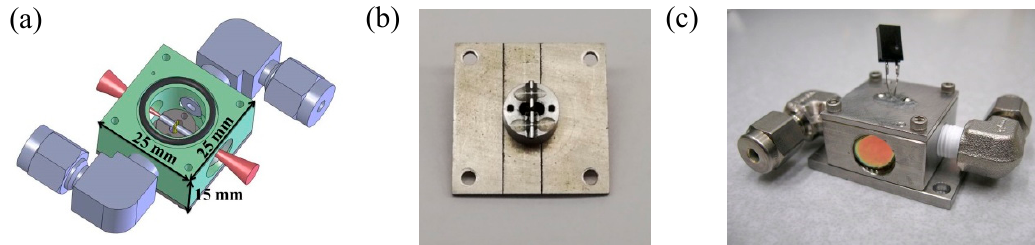
Figure 6. ( a ) CAD image of the free space MIR ADM; ( b ) photo of the top cap with spectrophone; ( c ) photo of the free space MIR ADM.